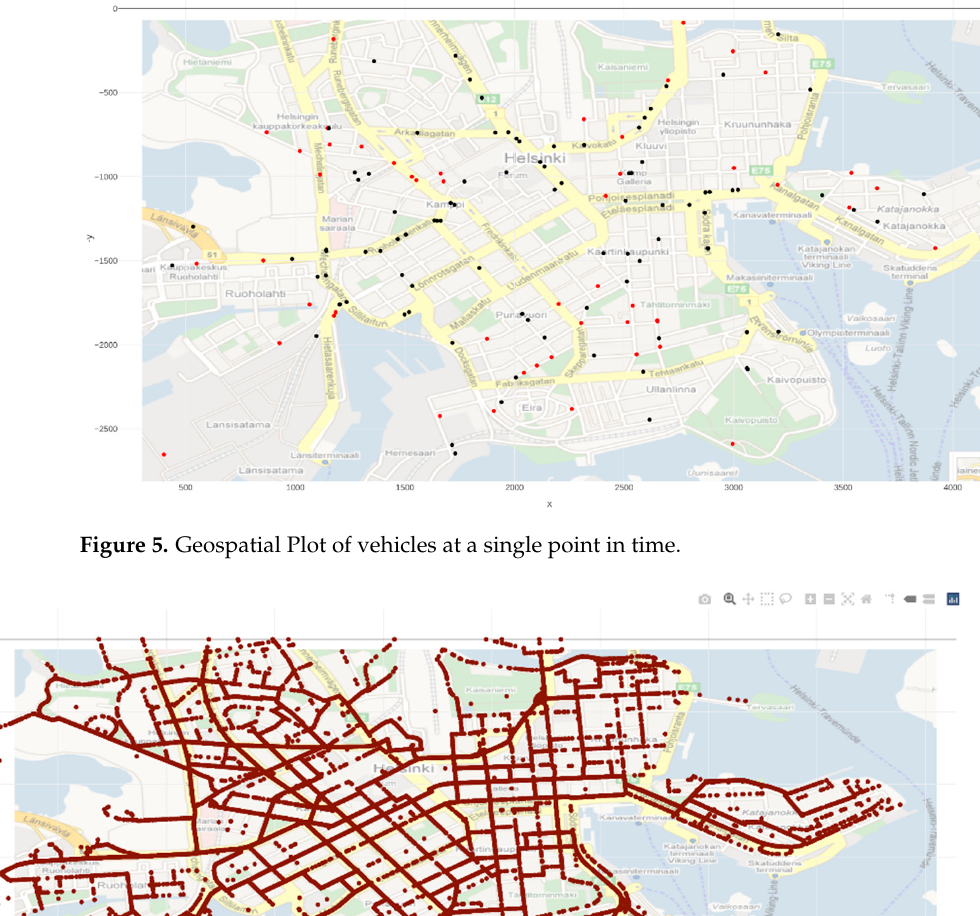
Figure 5. Geospatial Plot of vehicles at a single point in time.